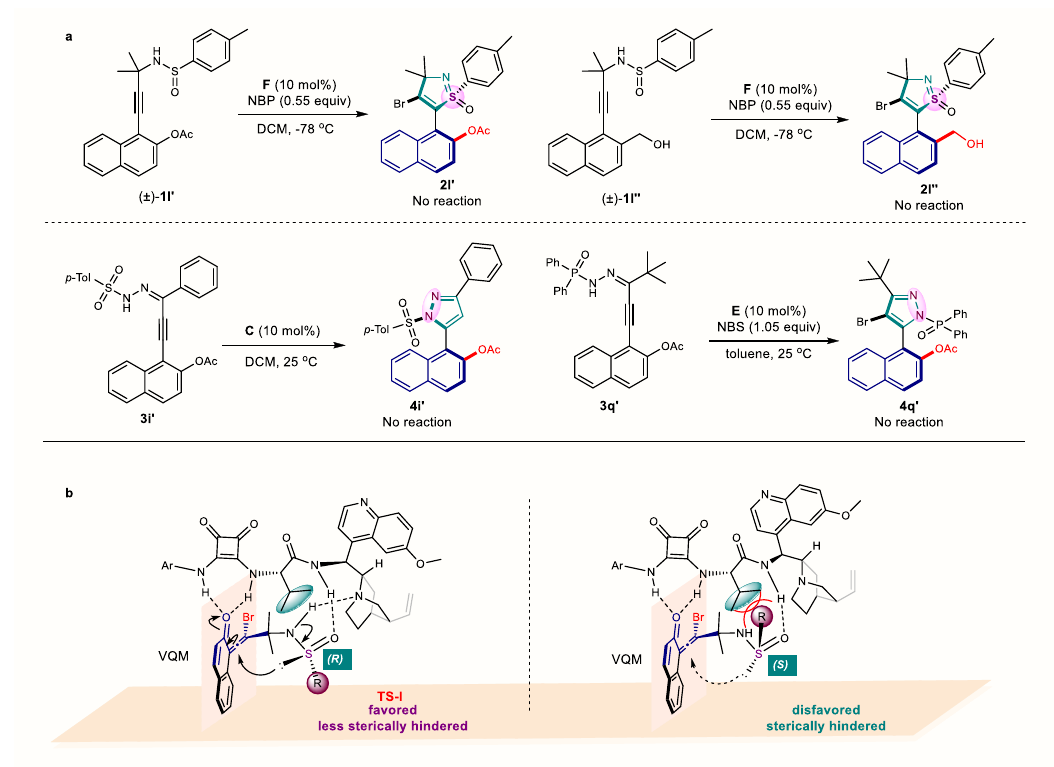
Fig. 7 Control experiments and proposed mechanism model. a Control experiments. b Proposed model for atroposelective 1,2-azole ring formation (naphthyl-isothiazole S-oxides as